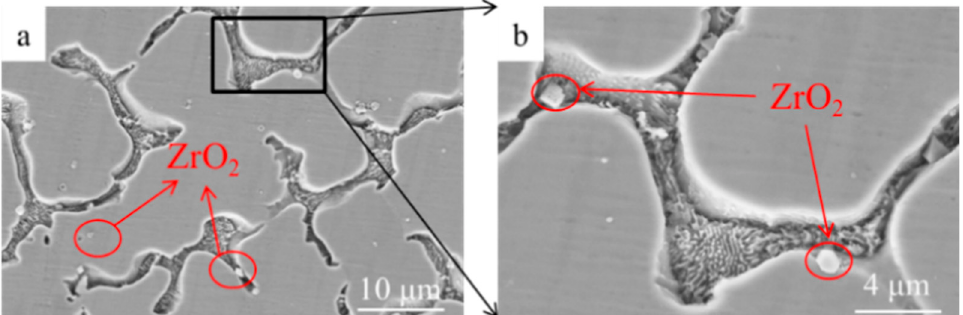
Figure 5. SEM images of the microstructure of 20% ZrO 2 : ( a ) distribution image of ZrO 2 , ( b ) enlarged image of a local area of ( a ).